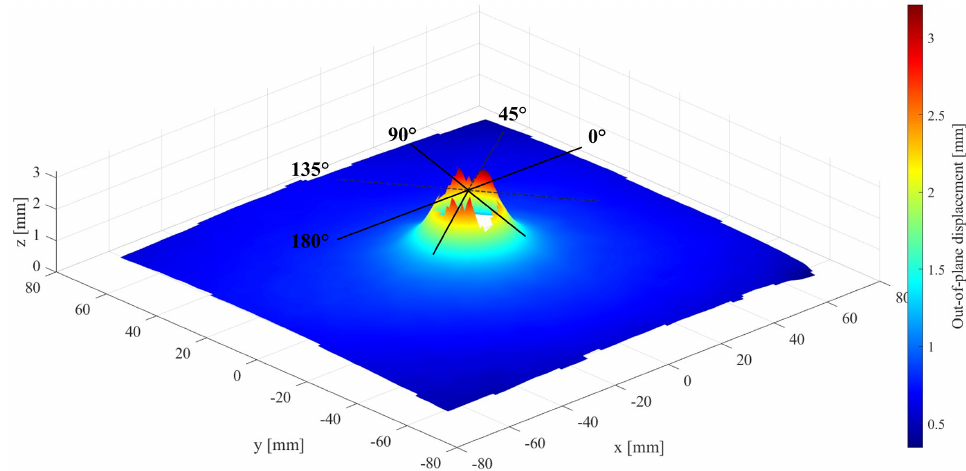
Figure 7. Configuration 2, test 2: 3D out-of-plane displacement of aluminum plate showing a local deformation around the impact